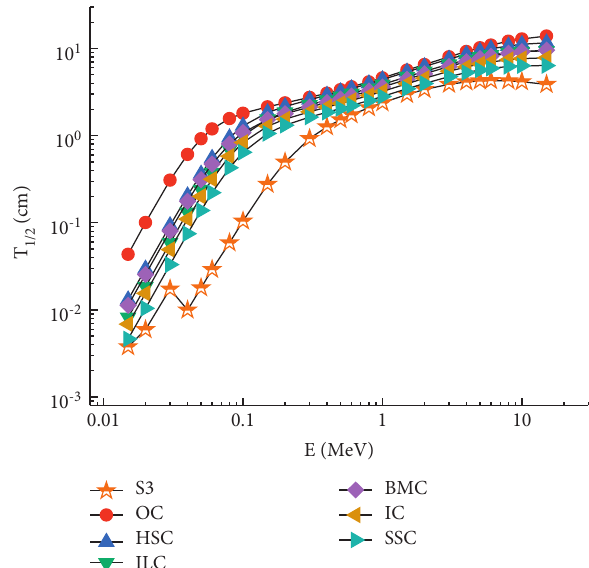
Figure 17: Comparison of the HVL values with different types of concrete